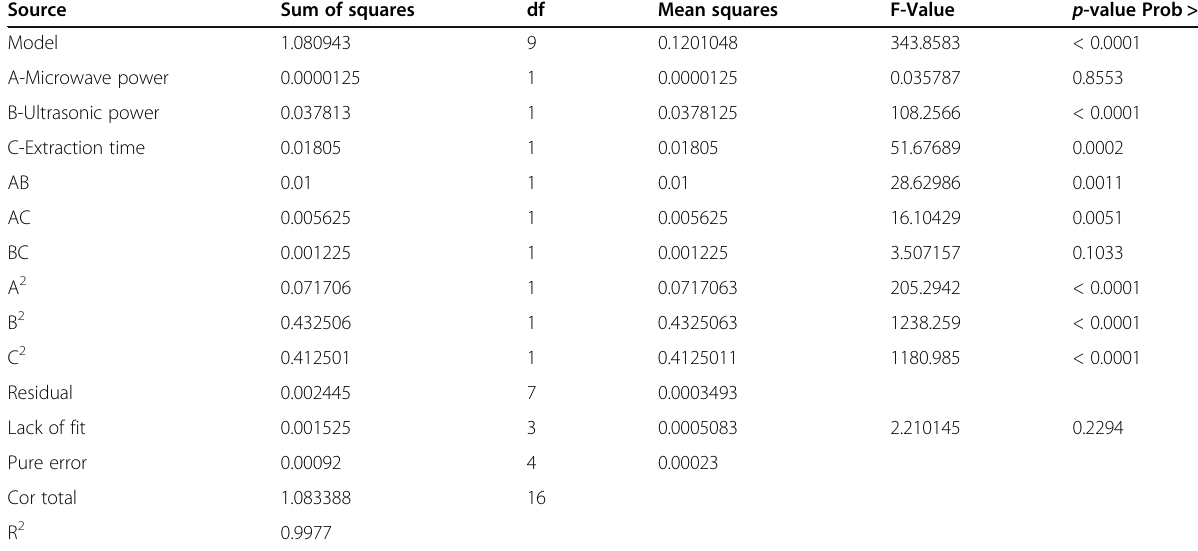
Table 2 Analysis of variance of response surface quadratic model Source Sum of squares df Mean squares